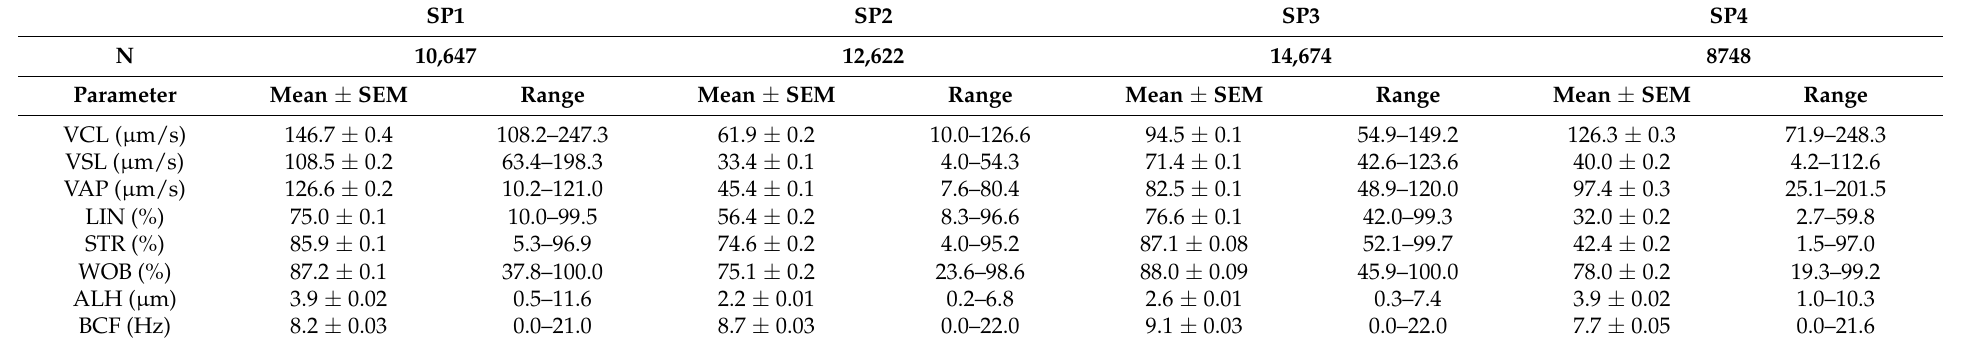
Table 2. Descriptive parameters (mean ± SEM; range) of the four sperm subpopulations (SP1, SP2, SP3, and SP4) identified in nonirradiated and irradiated samples diluted in the two extenders and packed into straws of different